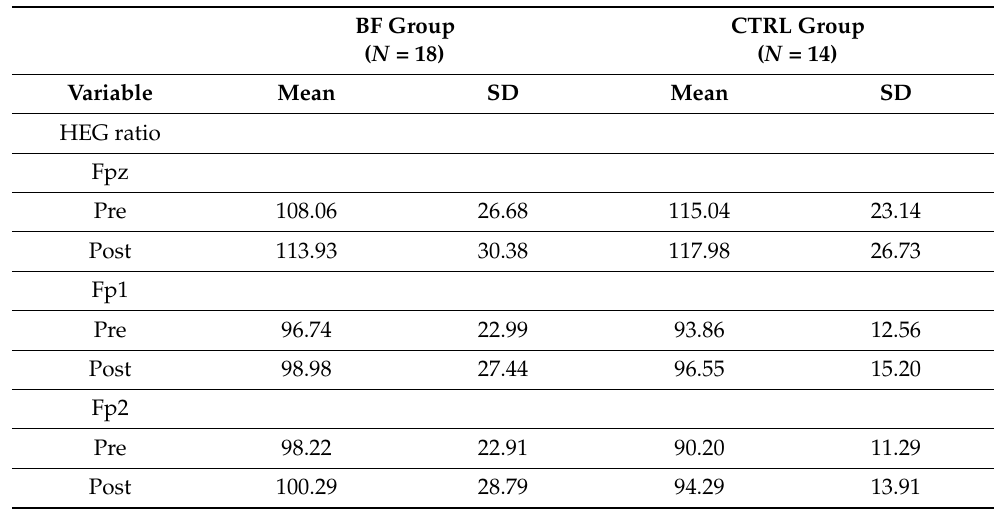
Table 2. Pre- and post-means and standard deviations (SD) of nirHEG ratio by site and by group.